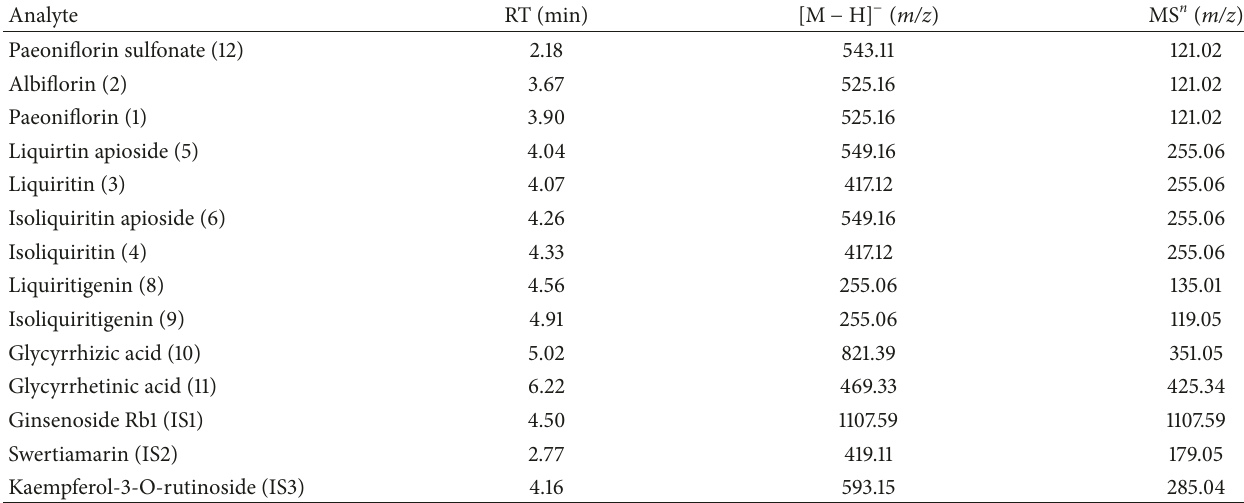
Table 1: MS analysis of parameters of detected compounds and internal standards